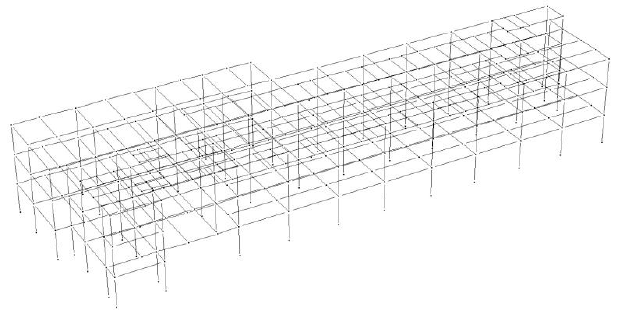
Figure 17. Finite element model of seismic structure.